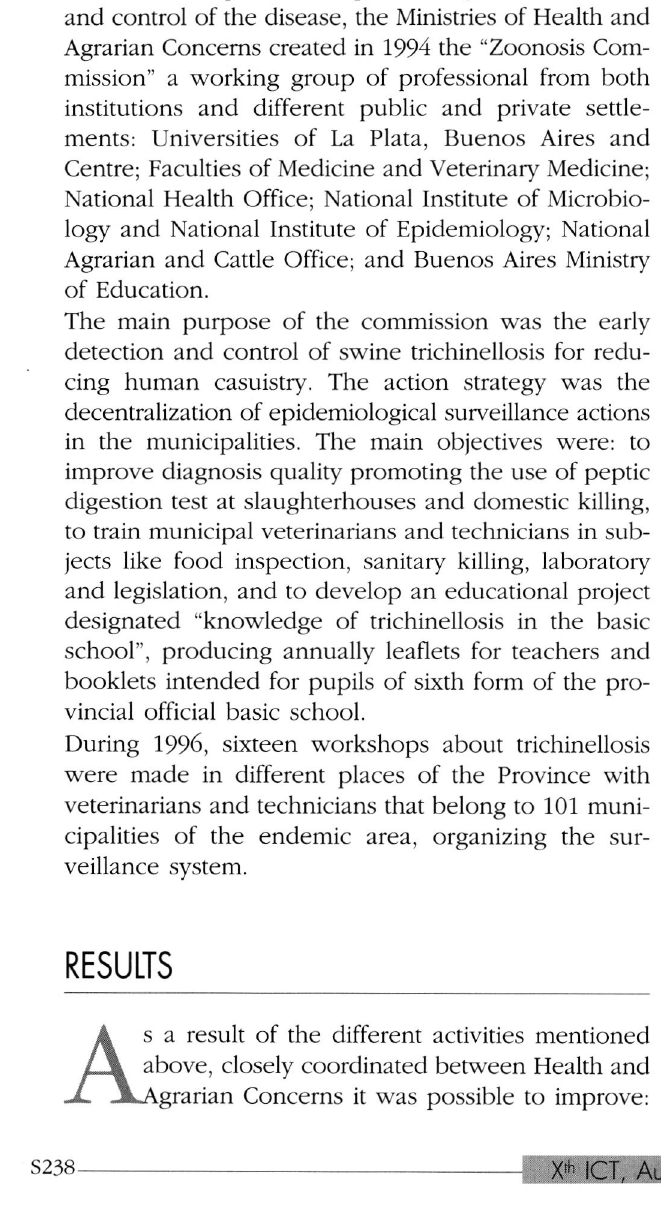
vince is recorded and published by Agrarian Concerns Ministry.